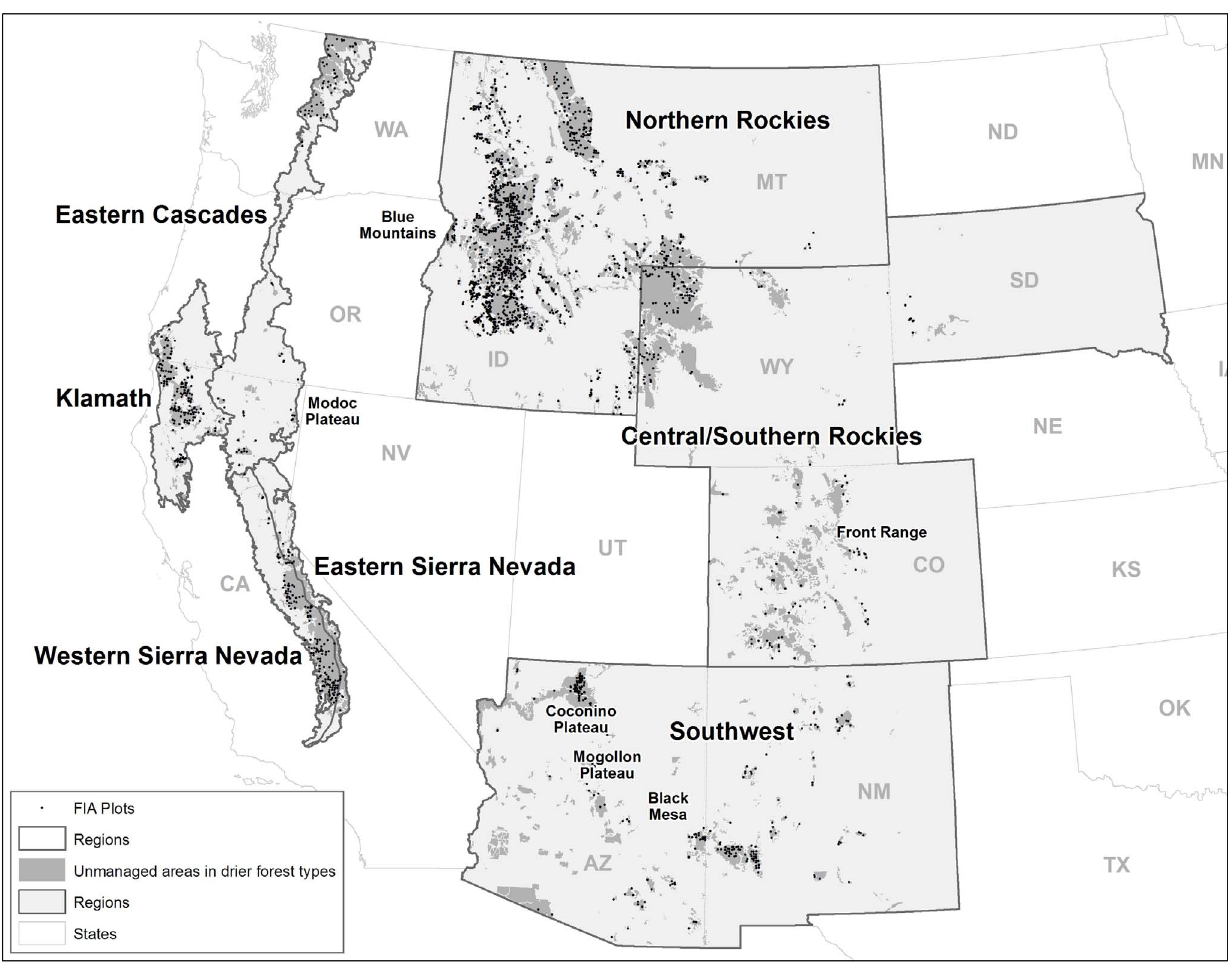
Figure 1. Study area. Dots indicate the general locations of Forest Inventory and Analysis (FIA) plots.